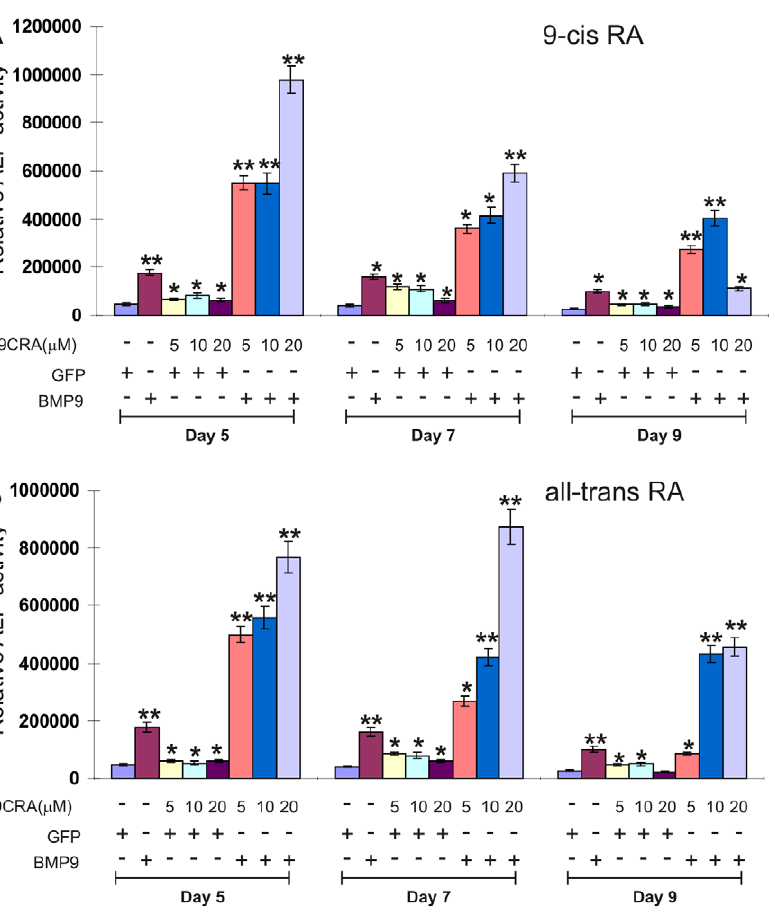
Figure 2. Retinoic acids and BMP9 act synergistically in inducing ALP activity in MPCs. ( A ) 9CRA induces ALP activity in MPCs. Subconfluent MEFs were infected with AdBMP9 (MOI=5) or AdGFP (MOI=5), followed by treatment with varying concentrations of 9CRA or solvent control. ALP activity was measured at the indicated time points. Each assay condition was carried out in triplicate in at least two independent batches of experiments. ‘‘*’’, p , 0.05 ; ‘‘**’’, p , 0.001 (vs. control groups). ( B ) ATRA induces ALP activity in MPCs. MEFs were infected with AdBMP9 (MOI=5) or AdGFP (MOI=5), followed by treatment with varying concentrations of ATRA or solvent control. ALP activity was measured at the indicated time points. Each assay condition was carried out in triplicate in at least two independent batches of experiments. ‘‘*’’, p , 0.05 ; ‘‘**’’, p , 0.001 (vs. control groups).